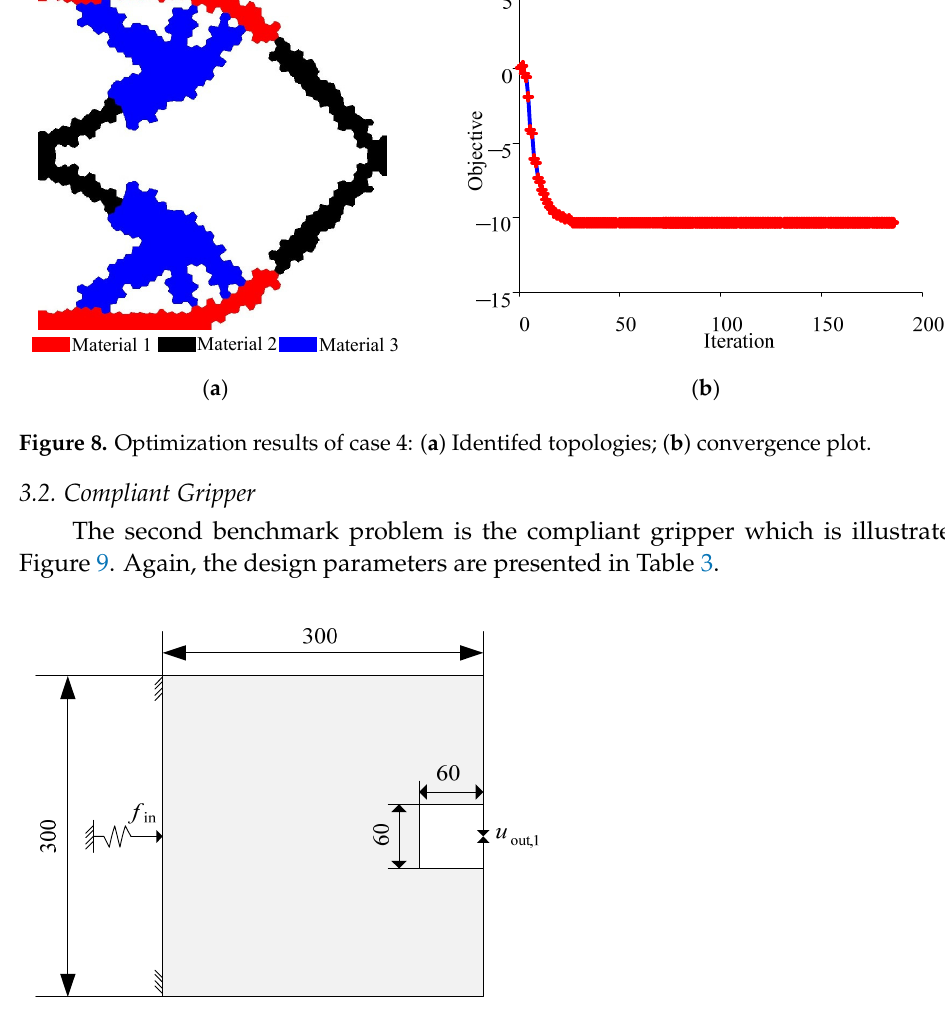
Figure 7. Optimization results of case 3: ( a ) Identifed topologies; ( b ) convergence plot.